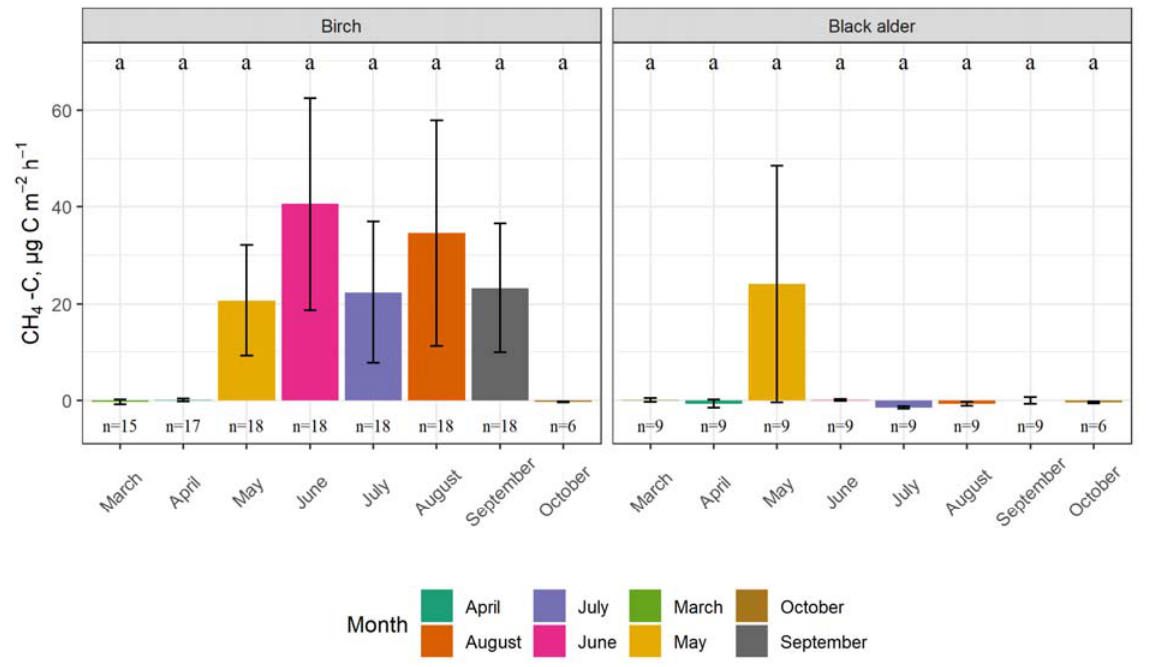
Figure 5. Average monthly CH 4 fluxes and removals from silver birch and black alder stems. Numbers below the bars (n) show number of measurements in each month. Different lowercase letters show statistically significant differences ( p < 0.05, Wilcoxon rank sum exact test) between tree species within the same month (no statistically significant differences were found).